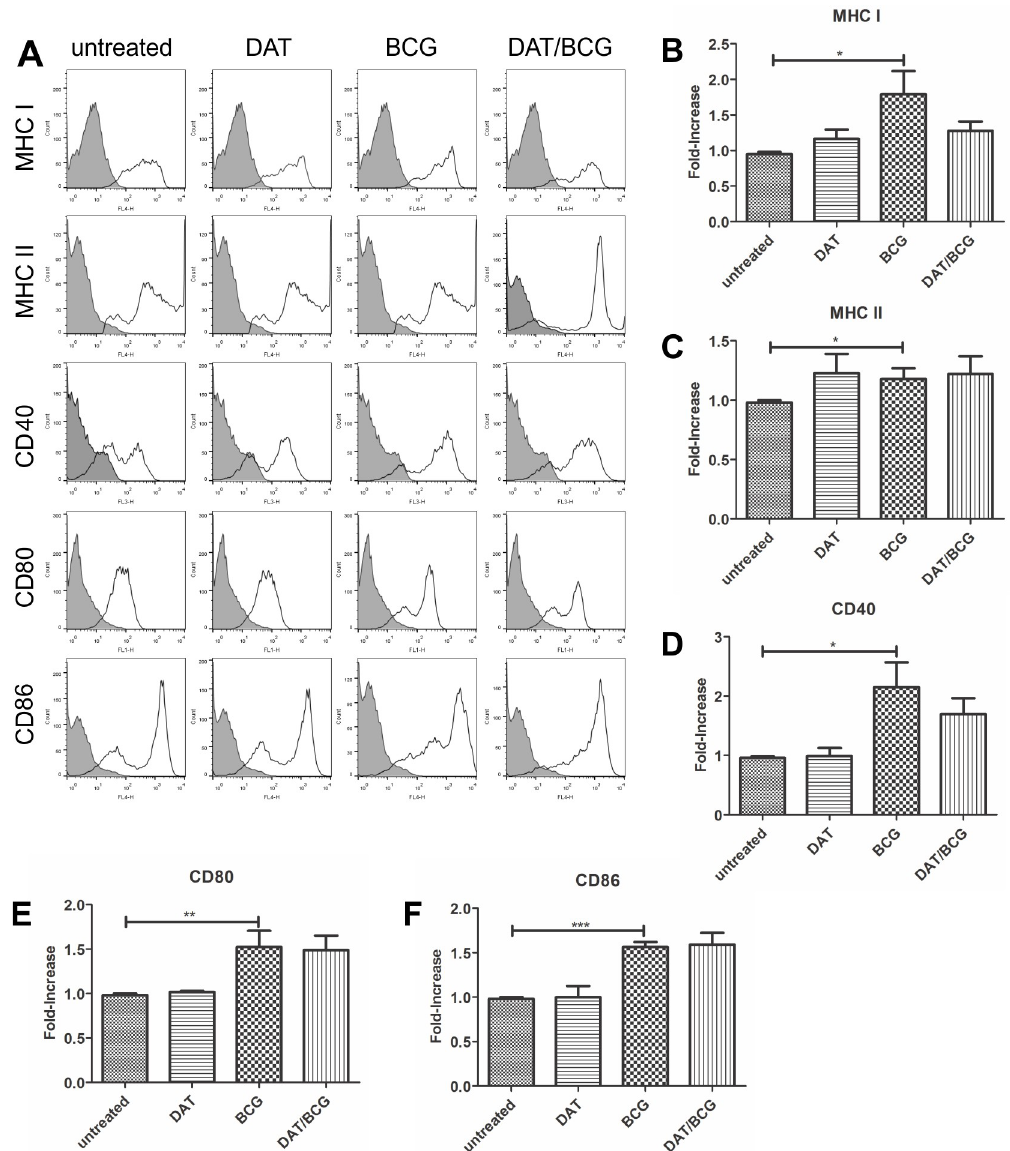
Fig 2. Di- O -acyl trehalose interferes with the maturation of DCs activated with BCG antigens. DC bone marrow precursors cultured with GM-CSF for six days were incubated with 20 μ g M . bovis /BCG cell wall antigens for 24 h; the maturation markers were analyzed by FACS in CD11c + cells (A). Increased expression of MHC-I, MHC-II and costimulatory molecules CD40, CD80 and CD86 are observed (p < 0.05; unpaired t Student’s test) (B-F). To determine the effects of DAT on DC maturation induced by BCG antigens, DC were treated with 10 μ g DAT for 1 h and then with mycobacterial antigens. DAT diminished the increased expression of MHC-I and CD40 induced by BCG (not significant) (B, D).